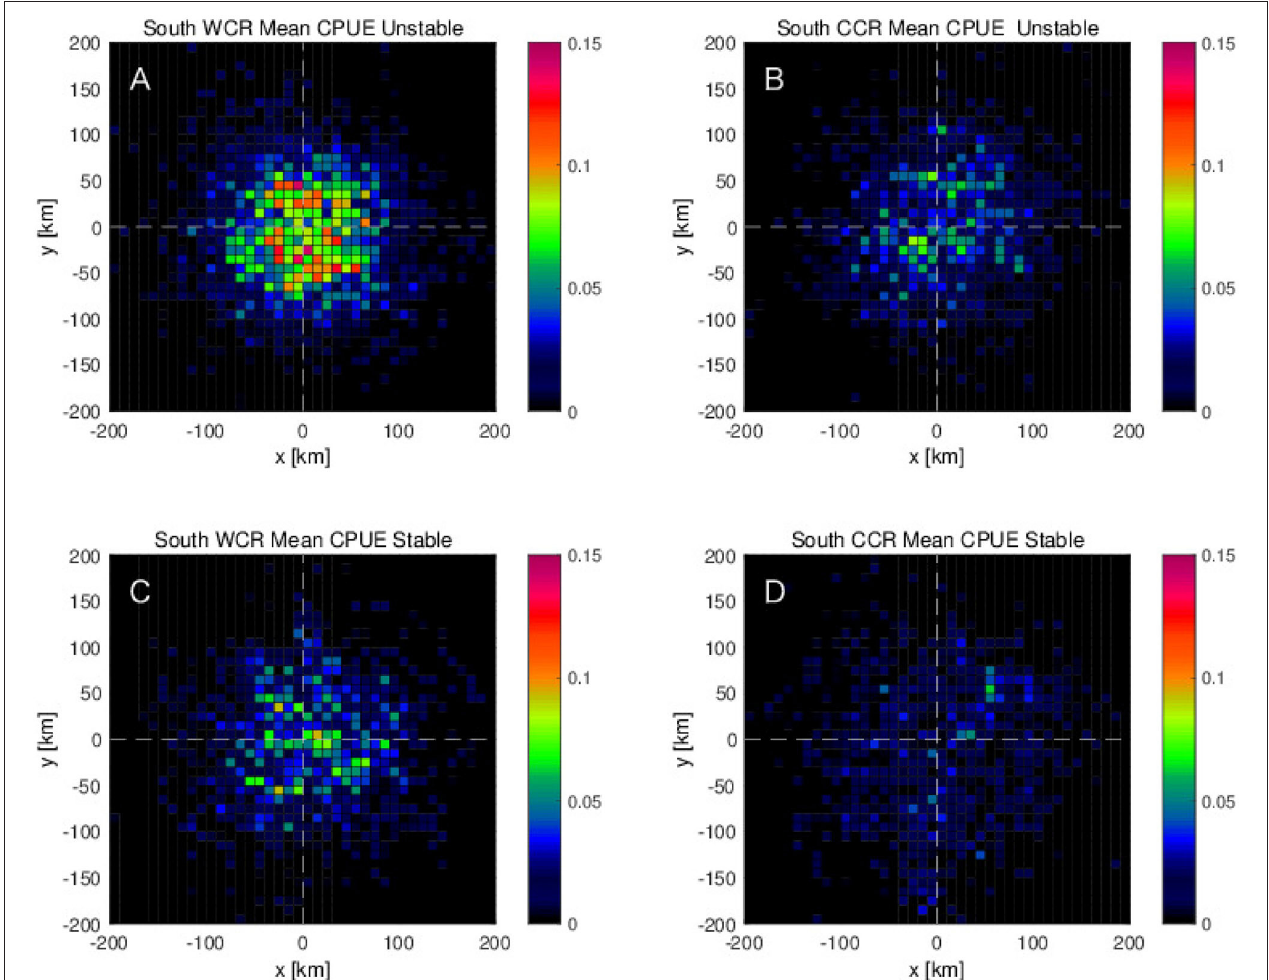
FIGURE 11 | Mean CPUE for the southern region, 140–175 ◦ E and 25–36 ◦ N as a function of distances from the center of eddies along zonal and meridional directions for (A,C) anticyclonic eddies (or warm-core rings: WCR) and (B,D) cyclonic eddies (or cold-core rings: CCR), which are closest to each swordfish fishing position in (A,B) unstable period 2006–2009 and in (C,D) stable period for years 2004, 2005, and